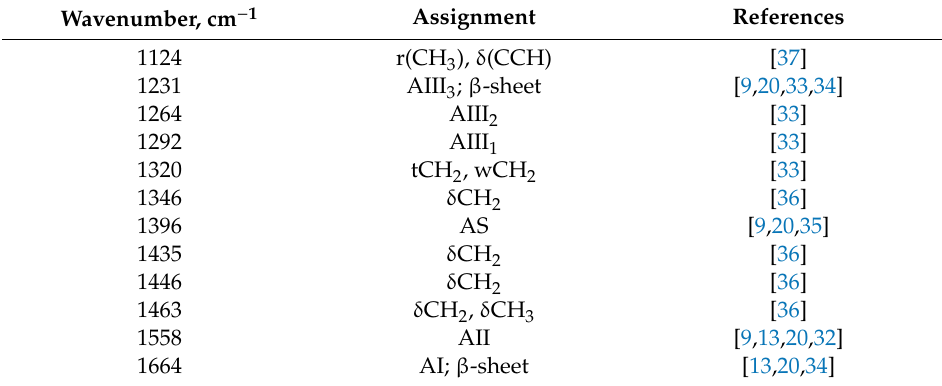
Abbreviations: r, rocking; t, twisting; w, wagging; δ ,